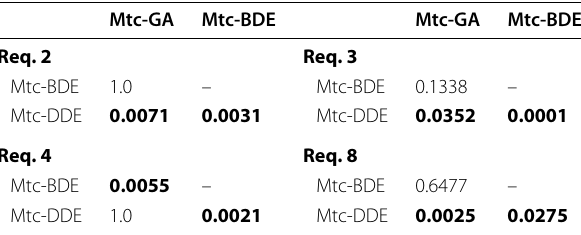
Table 12 Dunn test with Bonferroni α correction for the hit values in Table 11